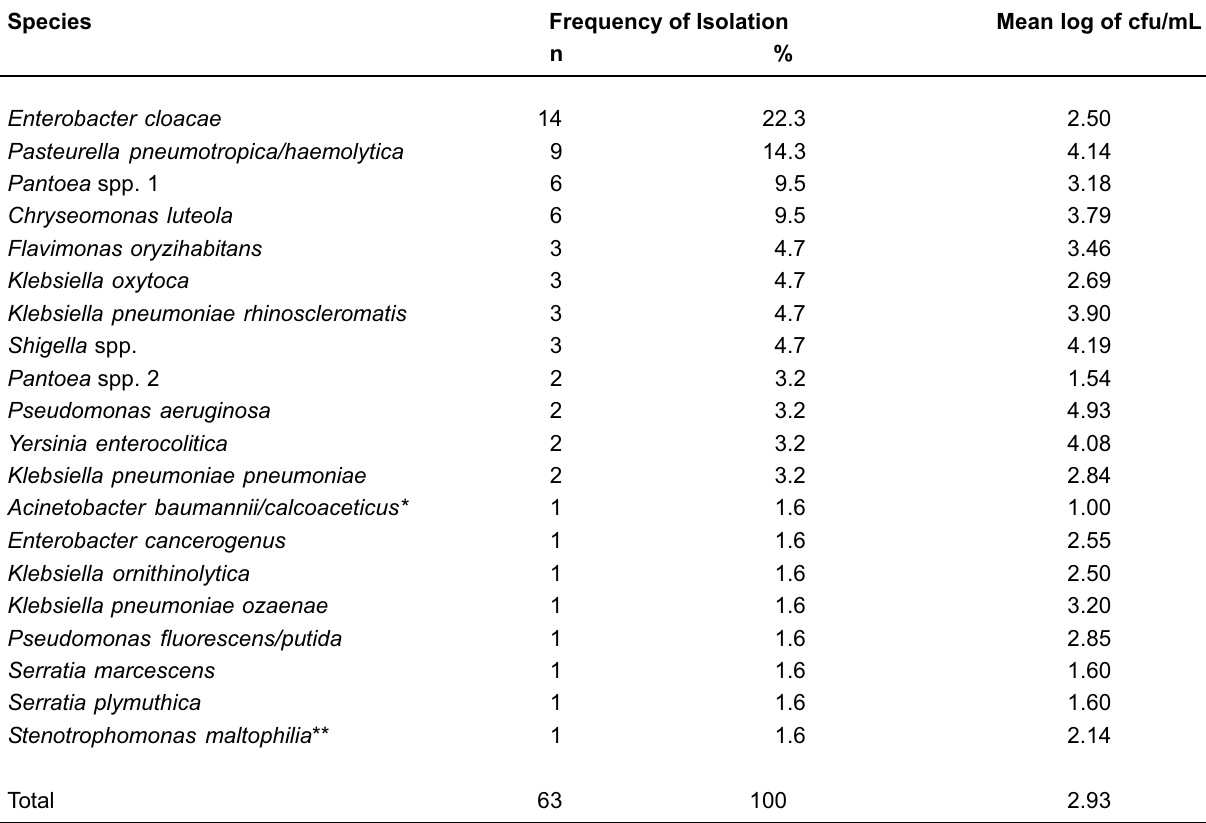
TABLE 2- Number of volunteers that presented Enterobacteriaceae, Pseudomonadaceae and Moraxellaceae on the tongue dorsum according to the smoking habit